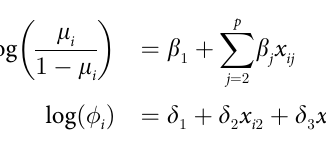
Table 4. Nonnull rejection rates (%), H